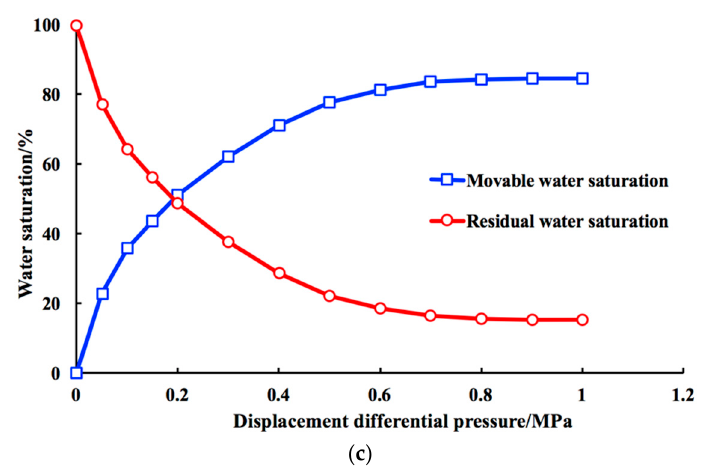
Figure 15. Water saturation versus displacement differential pressure based on the ImageJ gray analysis of the three visual micromodels. ( a ) Fracture type; ( b ) Cavity type; ( c ) Fracture-cavity type.